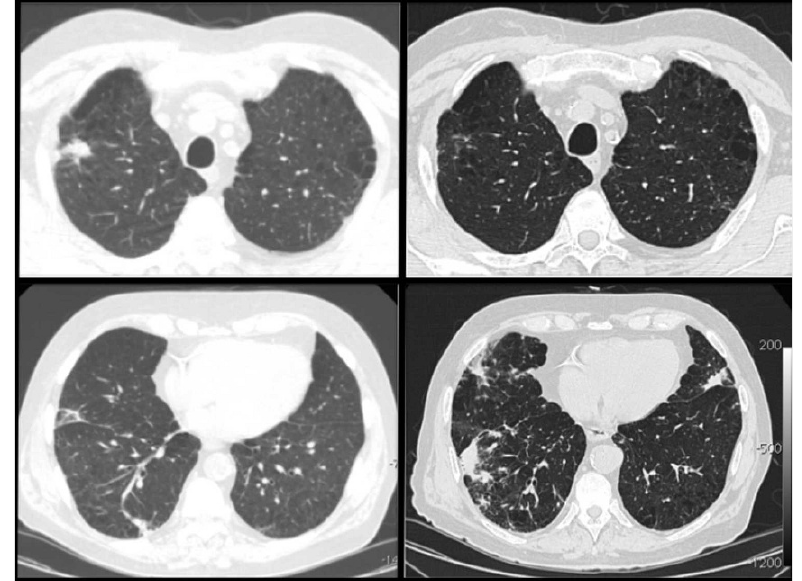
Figure 2 - Chest CT scans obtained in 2009. On the left column, solitary pulmonary nodule in the upper right lobe along with parenchimal bands in the inferior right lobe. Five months later, the right upper nodule disappeared, but other nodules surrounded with ground glass halo appeared in the inferior lobes